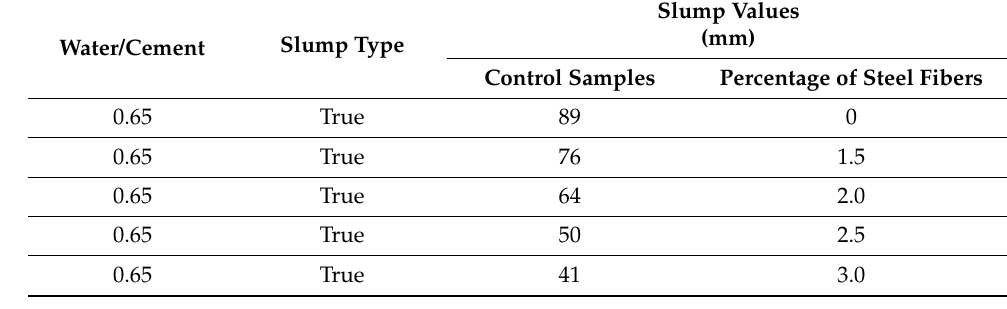
Table 5. Slump cone test results.